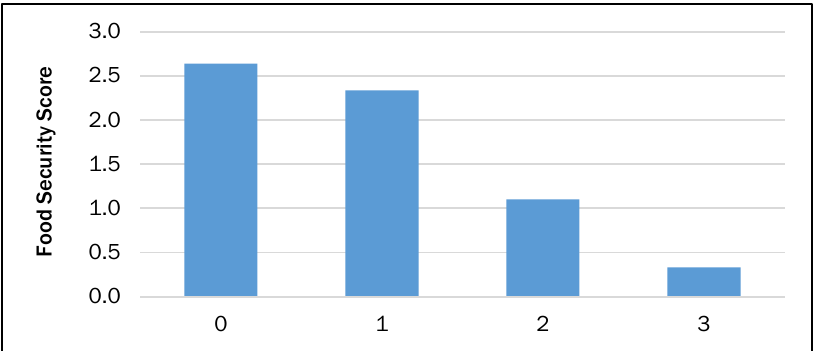
Figure 2. Mean Food Security for Participants Engaging in 0, 1, 2, or 3 Wild Food Procurement Activities Food Security scores between 0 and 1=high or marginal food security, 2 and 4=low food security, 5 and 6=very low food